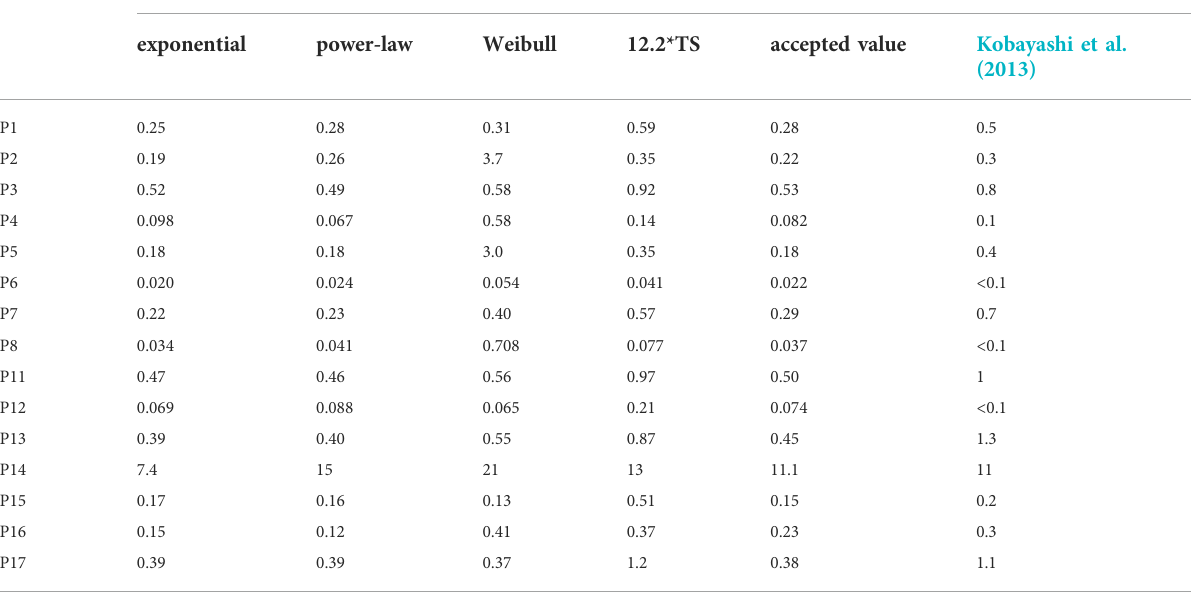
TABLE 3 Results of the tephra volume calculations for Sakurajima volcano.